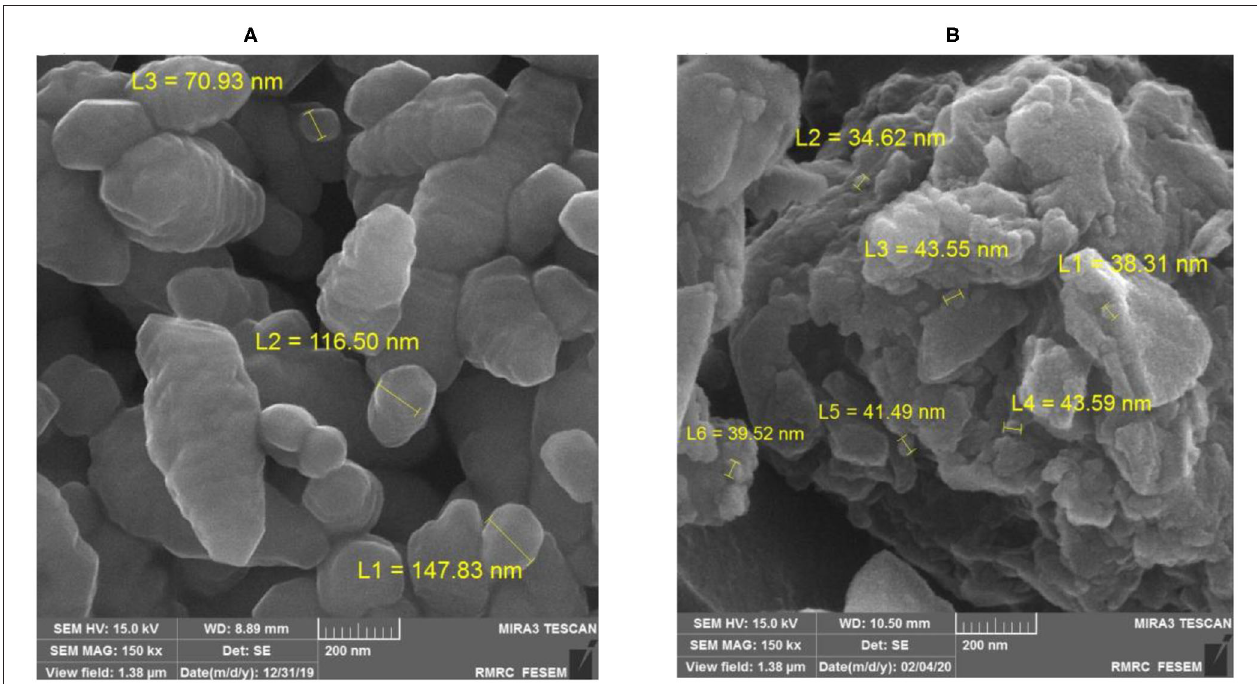
FIGURE 1 | Scanning electron microscope image of chitosan nanoparticles before (A) and after (B) loading with folic acid (at 15 kV and 150 k ×